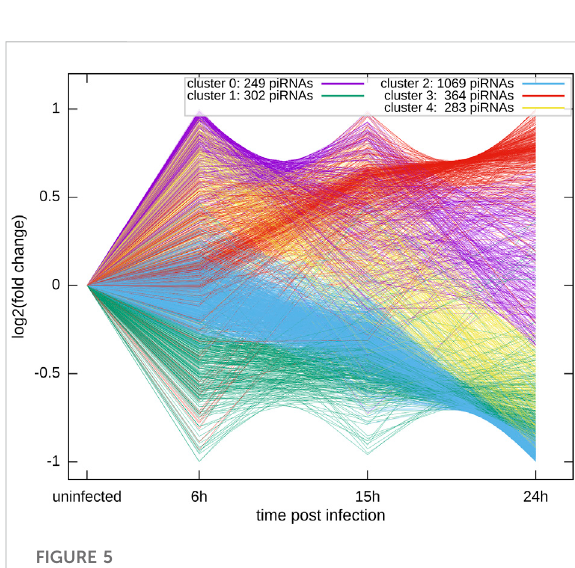
FIGURE 5 The k-means clustering of the temporal pro fi les of X -axis: time post-infection with RSV (cluster zero represents uninfected cells). Y -axis: normalized expression pro fi le, averaged over the replicates, and shown in the log 2